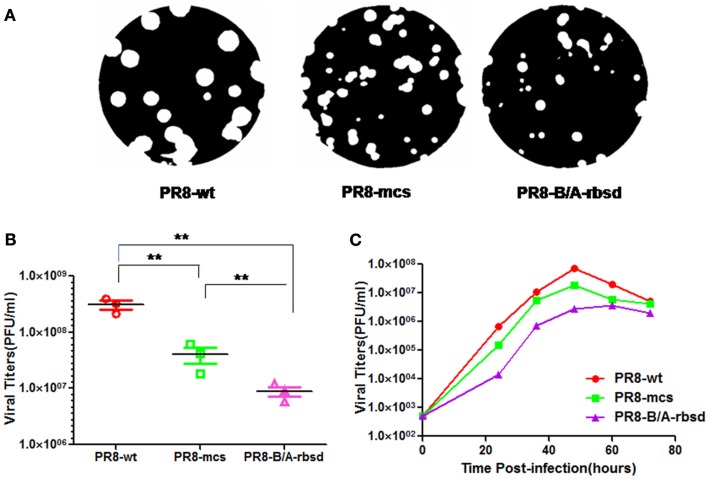
Growth characters of wild type and engineered PR8 influenza viruses. (A) Plaque formed by infection with wild type and engineered PR8 influenza viruses on monolayer MDCK cells. (B) Virus growth character in embryonated chicken eggs (**P < 0.05). (C) Virus growth curves on monolayer MDCK cells.